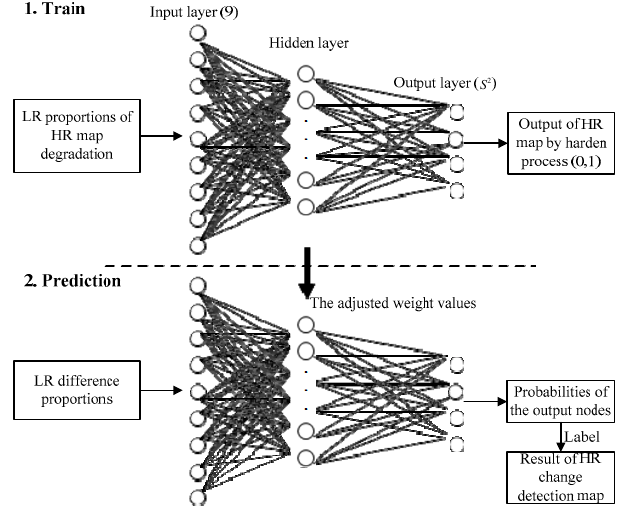
Figure 2. Back propagation neural network (BPNN) architecture for the proposed algorithm.